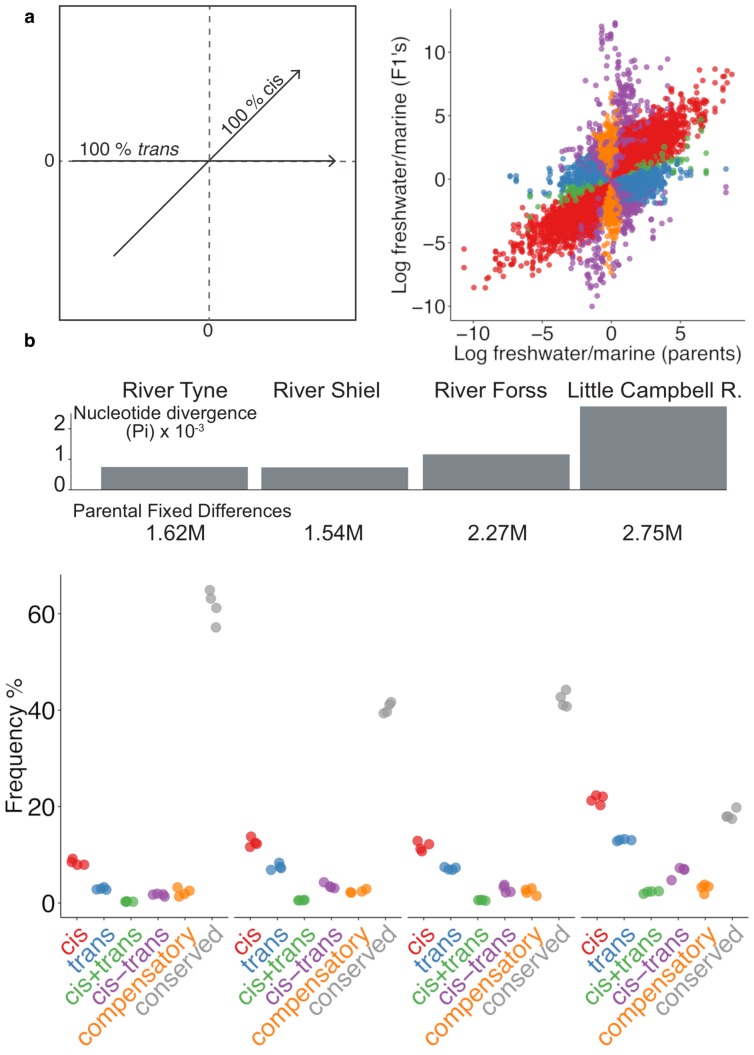
Expression divergence between marine-freshwater ecotype pairs is predominantly due to cis-regulatory divergence.(a) Regulatory divergence is categorized in six categories by comparison of the expression log2-ratio of the marine and freshwater parent to marine- and freshwater- allele-specific expression log2-ratio within an the F1 offspring (Landry et al., 2005). Individual data-points correspond to allele-specific expression values (y-axis) for each gene in each of four F1s relative to their parents (x-axis). Genes are colored according to their classification into different genetic architectures of expression divergence (red cis, blue trans, green cis+trans, purple cis-trans, gold compensatory, gray conserved. ‘Ambiguous’ and ‘conserved’ classes are omitted for clarity.) (b) cis-regulation is the predominant regulatory mechanism underlying gene expression divergence in all four river systems. Points show the overall frequency of regulatory divergence types, relative to the number of analyzed transcripts for each F1 offspring analysed. The proportion of expression divergence caused by cis-regulatory divergence, scales positively both with nucleotide divergence (gray bars) and the number of fixed differences (numbers beneath bars) between the marine and freshwater parents. ‘Ambiguous’ class is omitted for clarity.